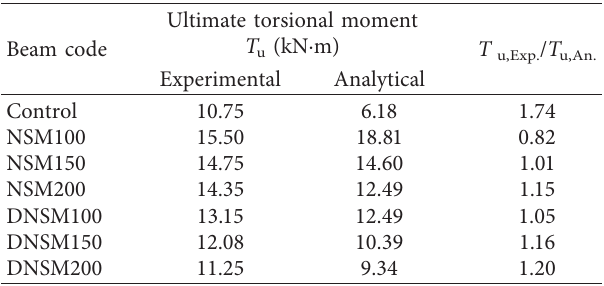
Figure 15: Failure modes of specimens under combined torsion and bending: (a) control specimen; (b) NSM100; (c) NSM150; (d) NSM200; (e) DNSM100; (f) DNSM150; and (g) DNSM200. Table 5: Comparison of the experimental and analytical ultimate torsional moments.